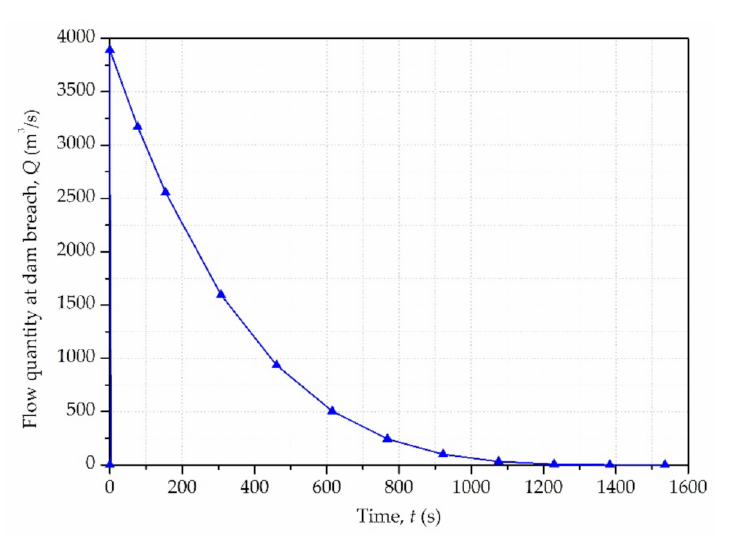
Figure 5. The hydrograph of tailings flow at dam